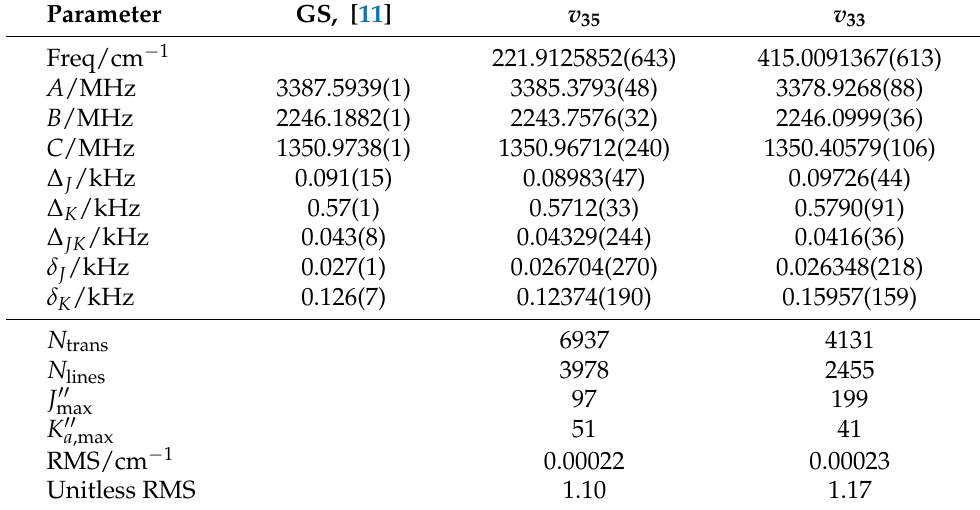
Table 4. Summary of the fitted parameters in the far-IR analysis of the ν 35 free -OH and ν 33 bonded -OH torsional modes. The GS parameters were fixed to the fitted values obtained by the microwave study of Caminati et al. [11]. 1 σ uncertainties are quoted in parenthesis in the units of the last digit. N trans is the number of fitted c -type transitions. N lines is the number of measured lines included in the fit. The table gives also the J (cid:48)(cid:48) max and K (cid:48)(cid:48) a ,max quanta and the RMS values (in cm − 1 and unitless).